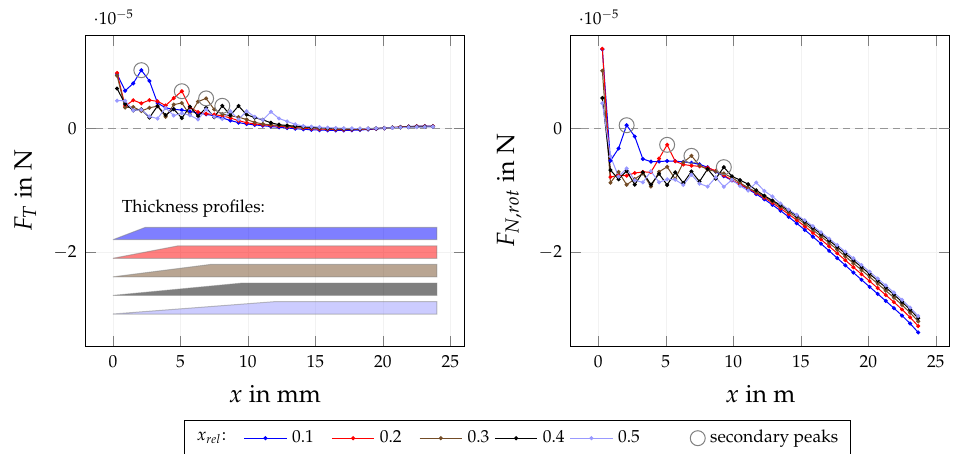
Figure 26. Distribution of tangential forces F t and rotation-induced normal forces F n , rot in central PM fragment row with increasing height over different relative channel lengths x rel . Sketches (left) lay out height profiles. Circular marks indicate secondary peaks.